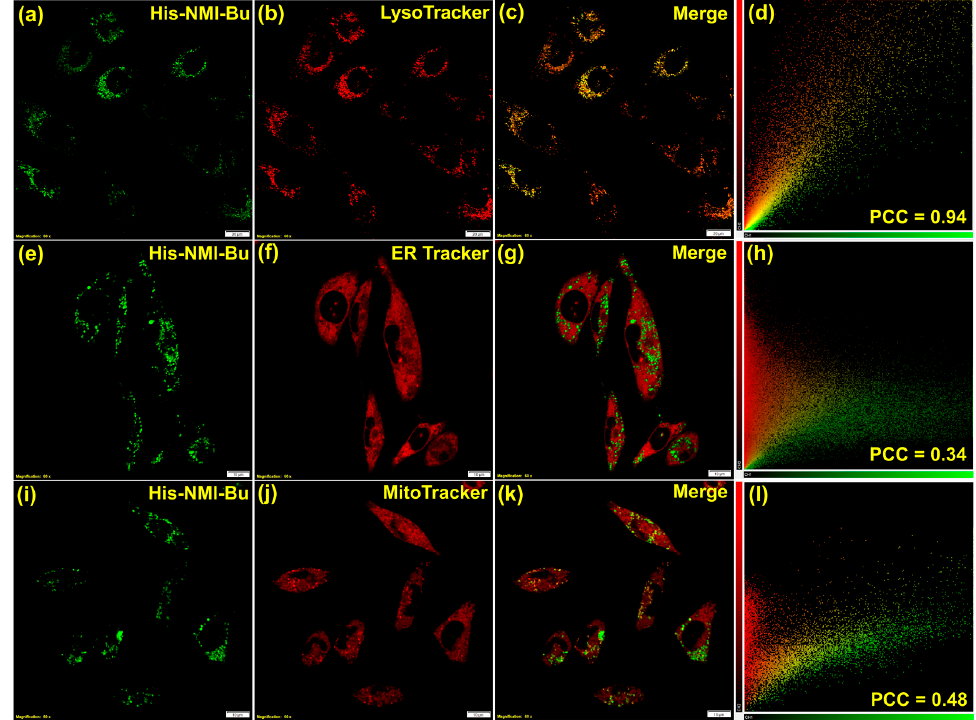
Figure 6. Confocal live cell colocalization experiments in BHK-21 cells. ( a , e , i ) show the FITC channel images ( λ ex = 488 nm, λ em = 500–540 nm) stained with 5 µM His-NMI-Bu ; ( b , f , j ) show TRITC channel images ( λ ex = 561 nm, λ em = 570–630 nm) stained with 0.3 µM LysoTracker Red, ER Tracker Red, and MitoTracker Red, respectively; ( c , g , k ) show the corresponding merge images; ( d , h , l ) shows the scatter plot to obtain the respective Pearson’s correlation coefficients.